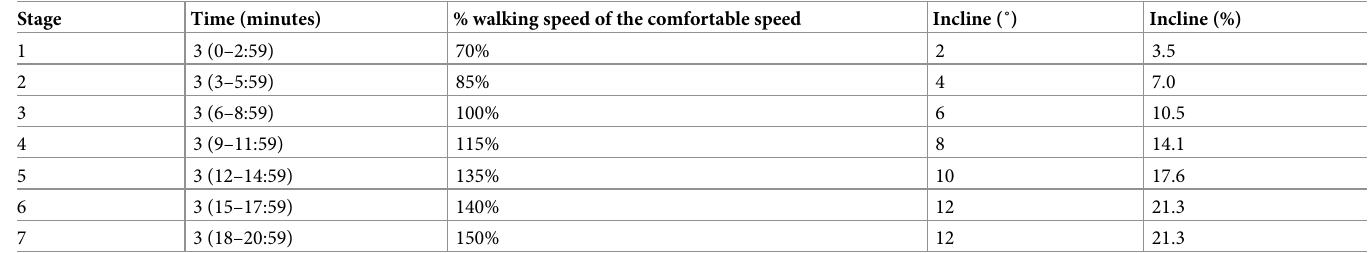
Table 1. Details of the fatigue